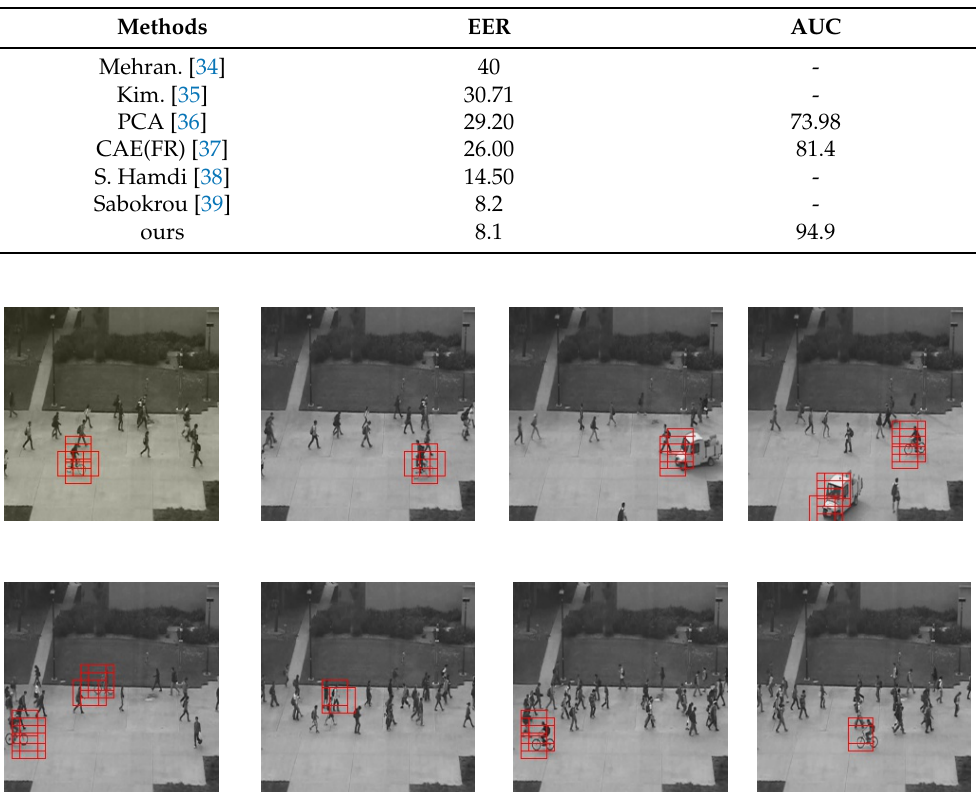
Table 3. EER and AUC for frame-level comparisons on the Ped2 dataset.